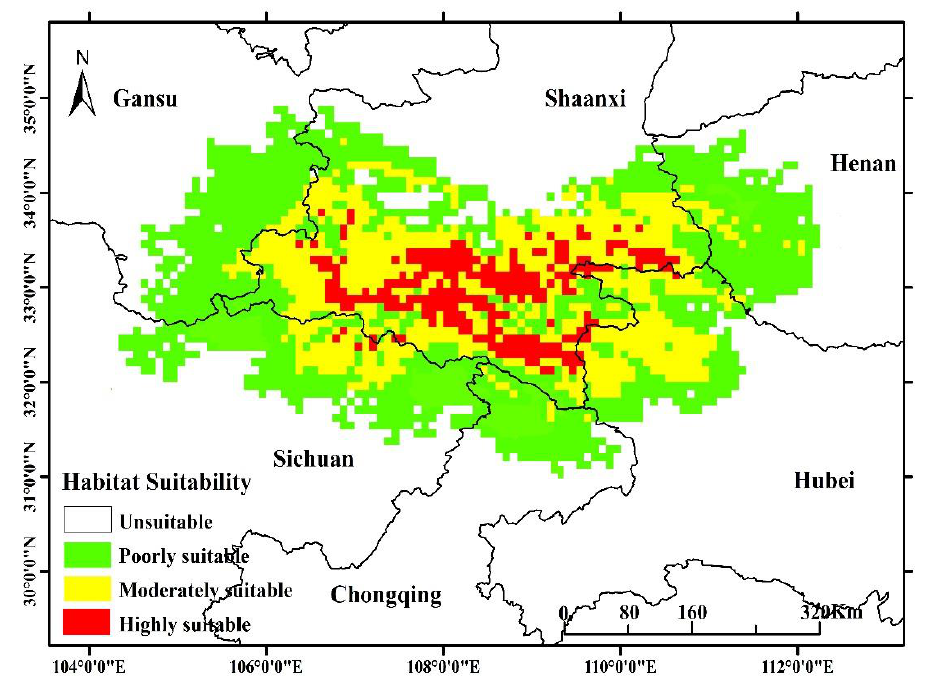
Figure 3. Current distribution of suitable habitat for Dendroctonus armandi in China.